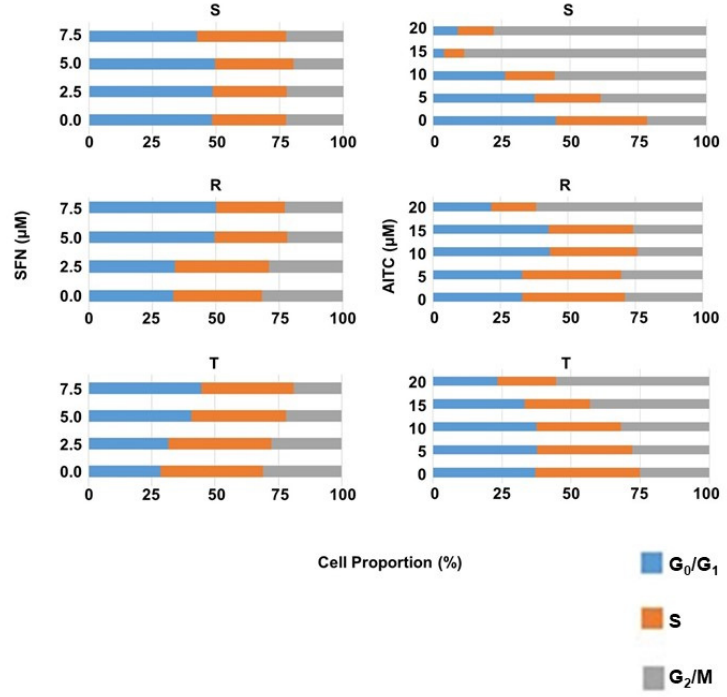
Figure 6. Summarization of the cell cycle phases (G0 / G1, S and G2 / M) of S, R and T cells after culture in the absence or presence of SFN for 8 h or AITC for 12 h at the given concentrations. Data are representative of three independent measurements, and the respective FACS histograms are documented in the Supplementary Files (Figure S3). AITC caused the greatest CC changes in S cells, which caused a concentration-dependent increase in the cell fraction in G2 / M (Figure 6). We also registered an increase in the proportion of cells in the G2 / M phase in R and T cells, but this was less pronounced than in S cells.